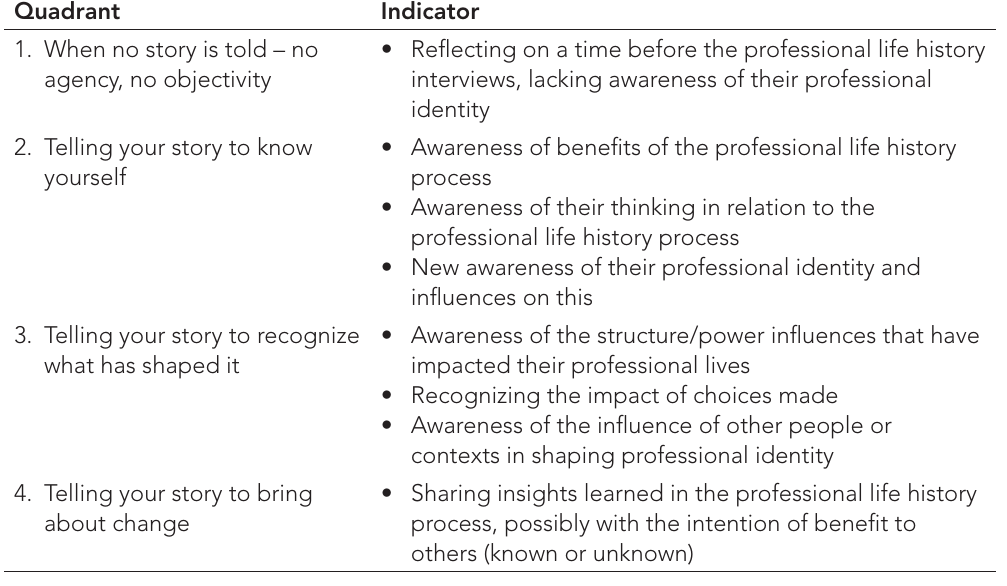
Table 2: Analysis indicators in relation to the four quadrants (Source: Author, 2021)